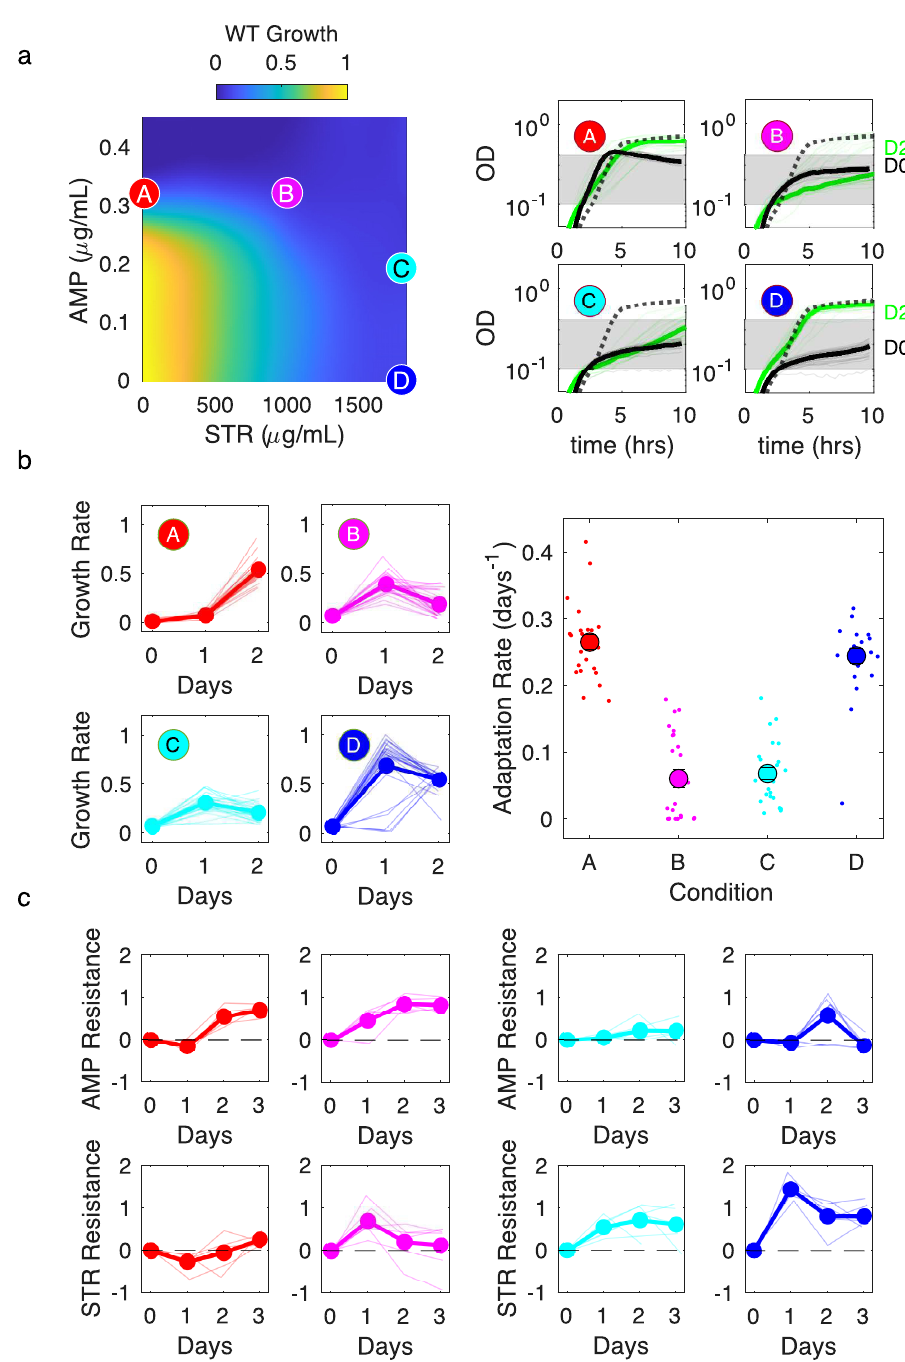
Fig 2. Antagonistic β -lactam and aminoglycoside combination slows adaptation with little cross-resistance. a) Left panel: per capita growth rate of ancestral populations as a function of ampicillin (AMP) and streptomycin (STR) concentrations. Circles correspond to different selecting conditions along a contour of constant inhibition. Drug concentrations (AMP,STR) are (0.3, 0) (red, A); (0.3, 1000) (magenta, B); (0.19, 1800) (cyan, C); and (0, 1800) (blue, D). Right panels: growth curves for the first (black) and last (green) days of evolution for each condition. b) Left panels: per capita growth rate over time for each condition. Dashed lines are drug-free growth curves in ancestor strains. Shaded region is OD range over which per capita growth rate is estimated. Right panel: average rate of growth adaptation over the course of the evolution. Adaptation rate in the single drug conditions (red and blue conditions, combined) is greater than that in the combined drug conditions (magenta and cyan, combined), 1-sided t-test (unequal variance), p < 10 − 4 . Error bars are ± standard error of the mean (SEM). c. Resistance to AMP (top